Question: Identify the chart type used in this figure.
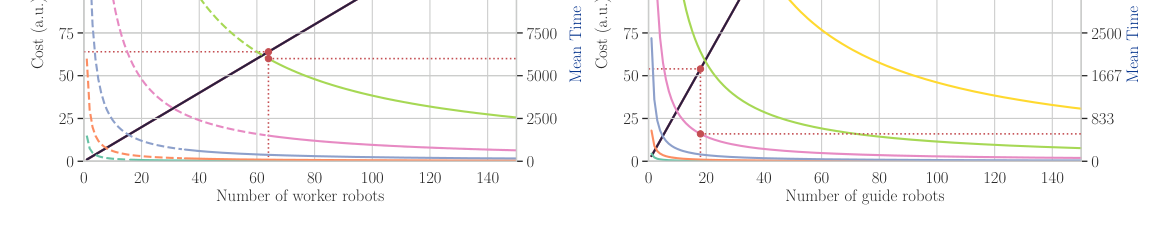
Answer: bar